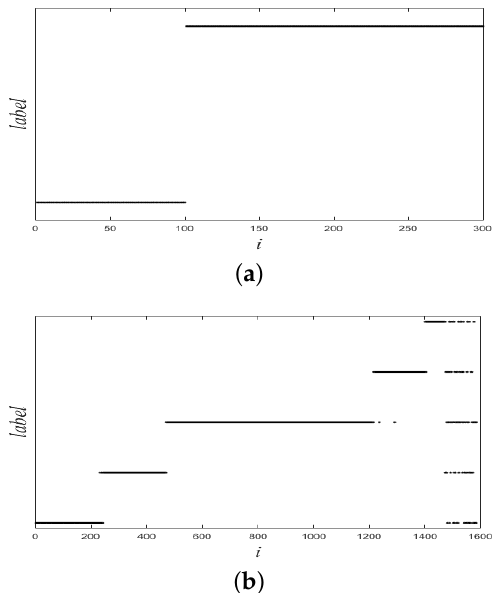
Figure 5. Ground-truth labels of two synthetic datasets. ( a ) Dataset 1. ( b ) Dataset 2.